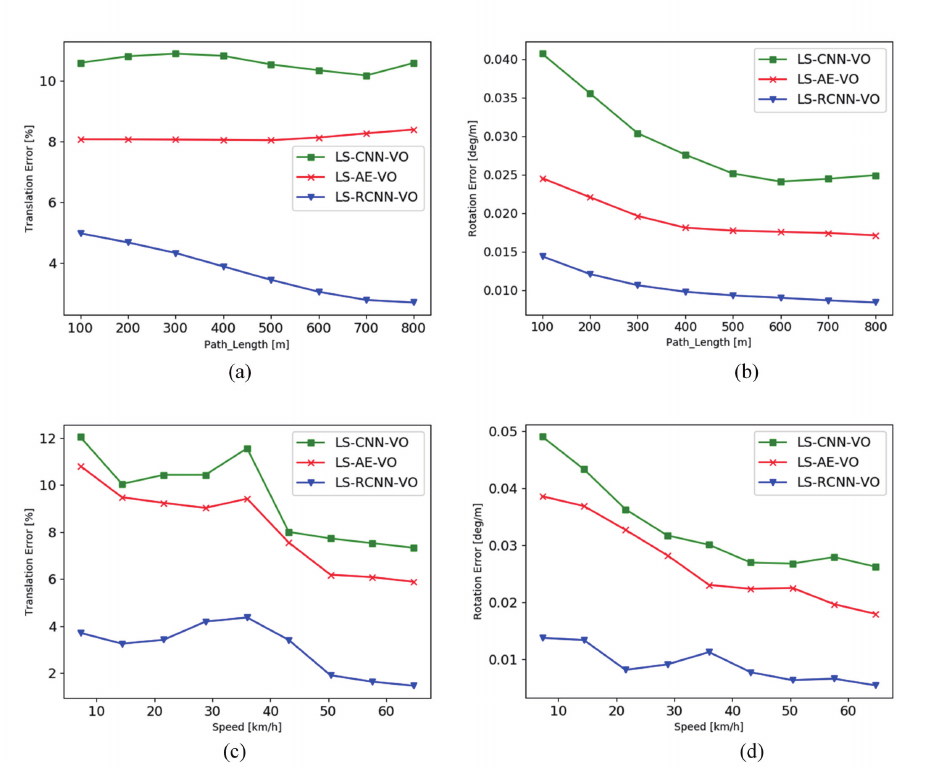
Figure 7. Comparison of the ATE and the ARE of the three models at different path lengths and speeds on Malaga dataset. ( a ) ATE versus path length, ( b ) ARE versus path length ( c ) ATE versus speed, and ( d ) ARE versus speed.